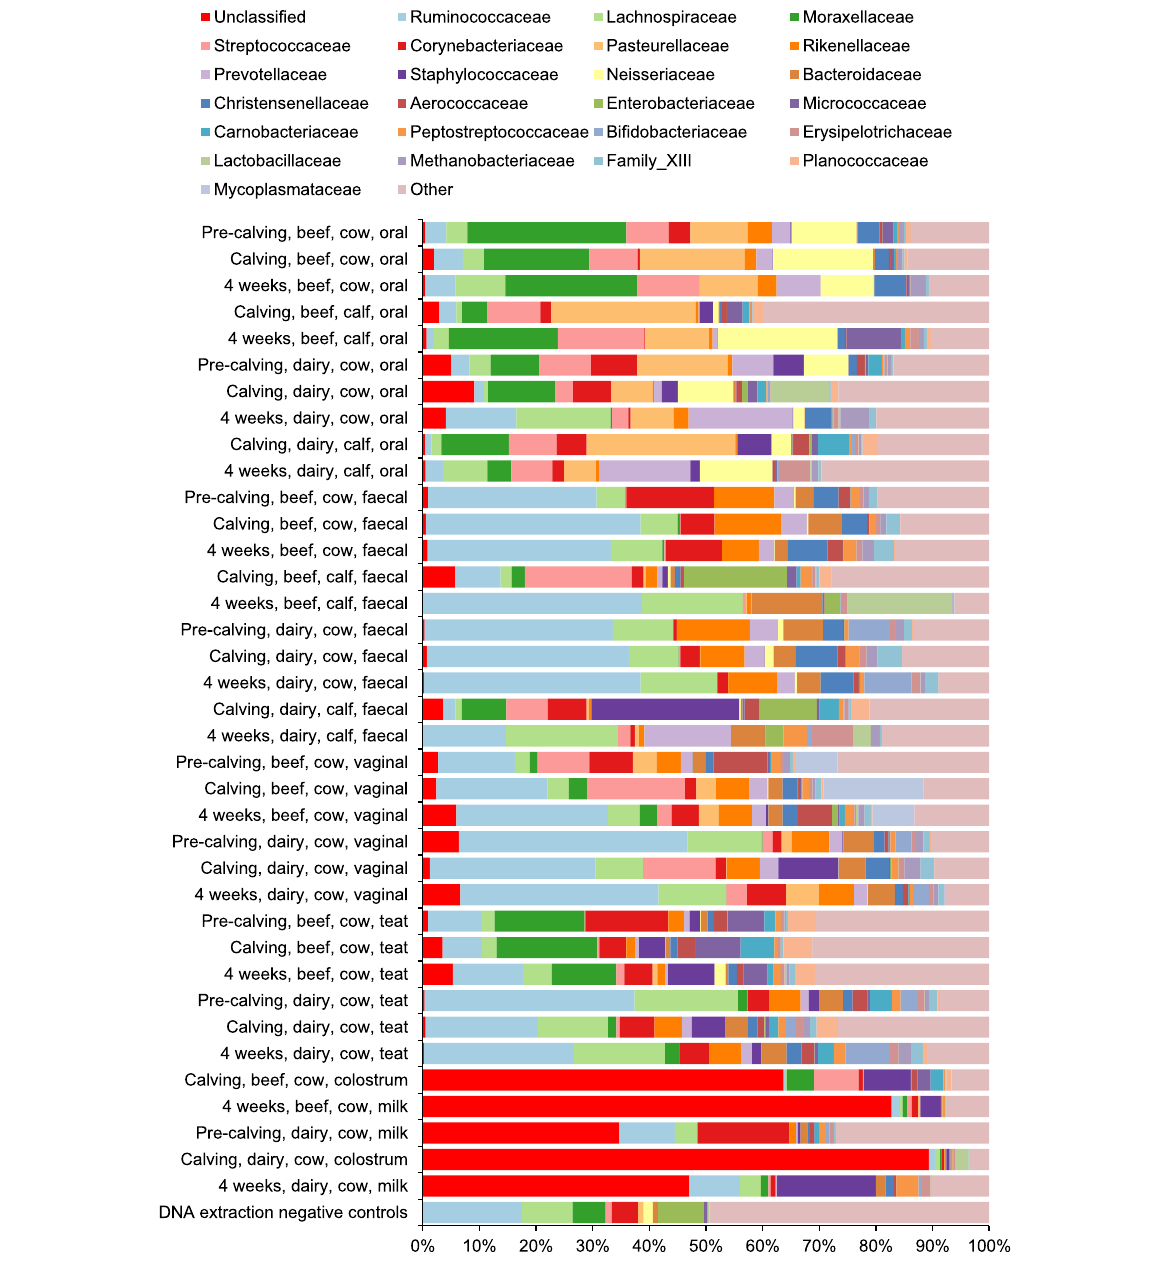
Fig. 1 The relative abundance of taxonomic family in each group of samples. The mean relative abundance of the most frequently classified families across all samples. Less frequently identified families are grouped as “ Other ” . Unidentified families are grouped as “ Unclassified ” . The number of individual animals in each group: each sample N = 5 unless no reads were produced, therefore “ DNA extraction negative controls ” N = 6 and “ 4 weeks, dairy, cow, milk ” N =